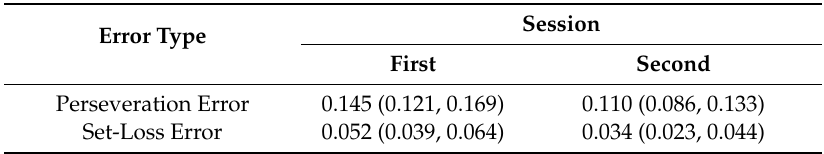
Table A3. Descriptive statistics of conditional error probabilities for first and second testing sessions (mean with 95% credibility interval in parentheses).